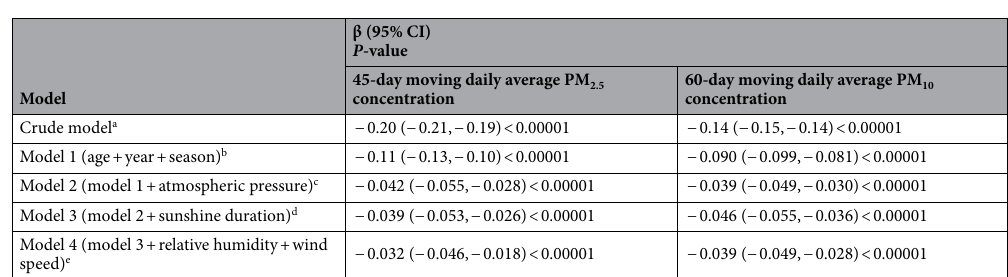
Table 2. Associations of the maximum cumulative effects of PM and maternal serum 25OHD levels during the second trimester in models adjusted for different temporal and meteorological factors. PM particulate matter, PM 2.5 particulate matter with an aerodynamic diameter of ≤ 2.5 μm, PM 10 particulate matter with an aerodynamic diameter of ≤ 10 μm, 25OHD 25-hydroxy vitamin D, CI confidence interval. a Not adjusted. b Adjusted for year, age and season. c Adjusted for year, age, season, and corresponding-day moving daily average atmospheric pressure. d Adjusted for year, age, season, the corresponding-day moving daily average atmospheric pressure and sunshine duration. e Adjusted for year, age, season, the corresponding-day moving daily average atmospheric pressure, sunshine duration, relative humidity and wind